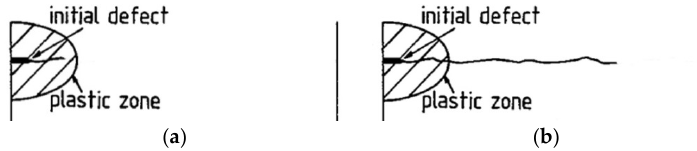
Figure 7. Schematic representation of ( a ) short-crack growth within a cyclic plastic zone; and ( b ) long crack growth beyond the boundary of a cyclic plastic zone.